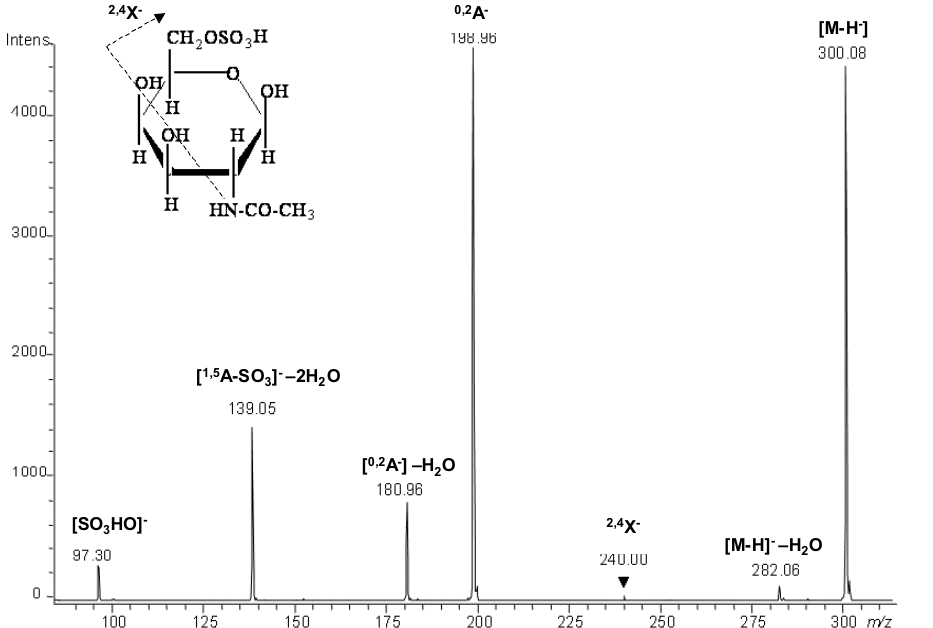
Figure 4. Fully automated chip (-) nanoESI HCT CID MS 3 of the singly deprotonated fragment ion detected in spectrum in Fig. 3 at m/z 300.09 and assigned according to mass calculation a composition of monosulfated GalNAc - . Diagnostic ion for GalNAc (6S) is marked by ( ▼ ). Conditions are the same as for the experiment in Fig. 3.